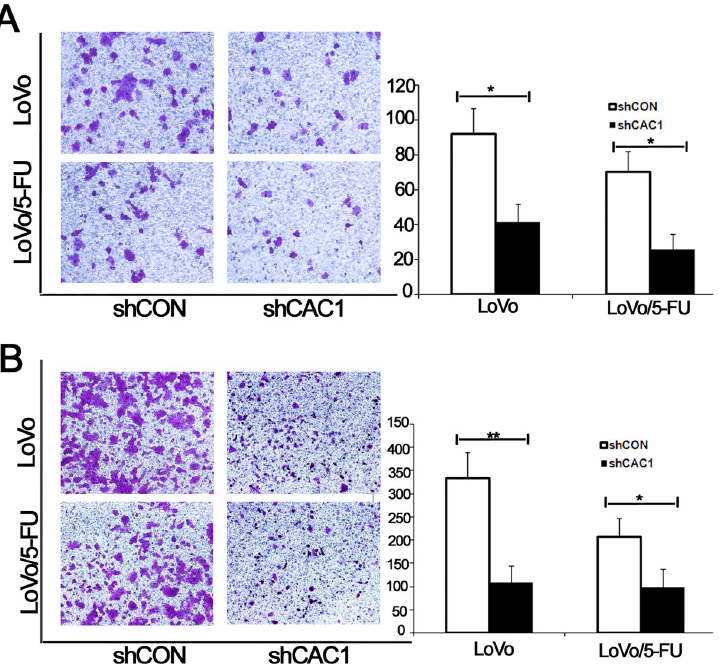
Fig 7. CAC1 knockdown reduced the invasive and migration ability of LoVo and LoVo/5-FU cells. (A) Cell invasion assay and (B) cell migration assay were detected in LoVo and LoVo/5-FU cells transfected with shCAC1 and shCON, respectively. � P < 0.05, �� P <